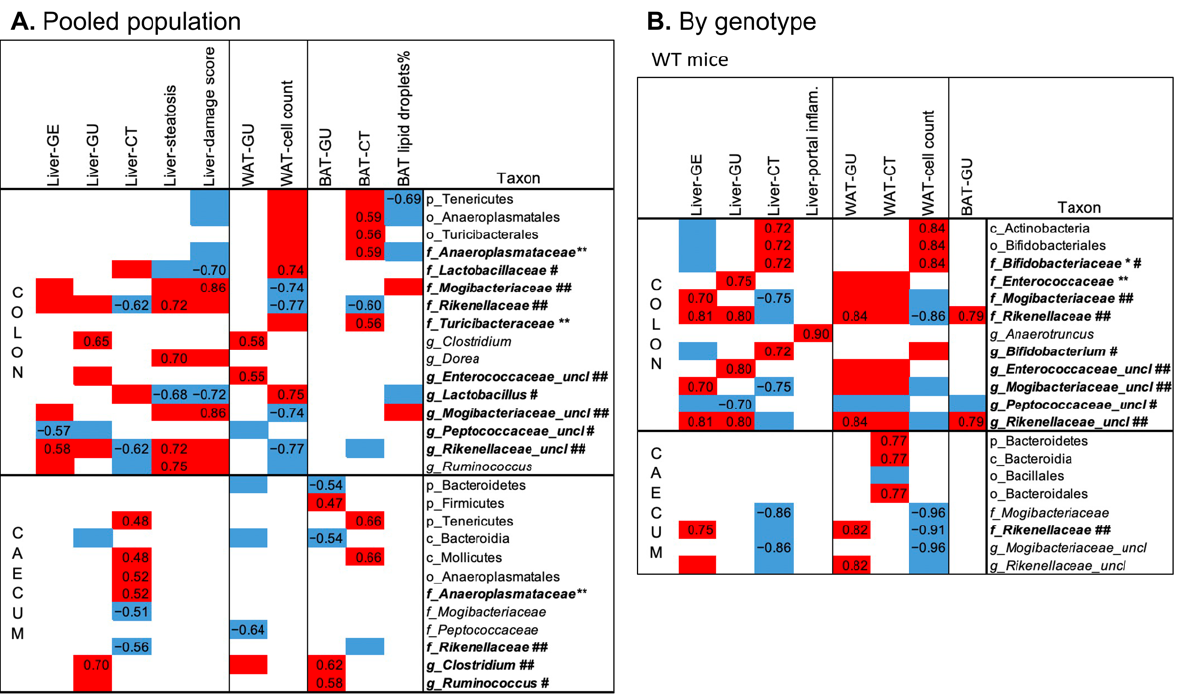
Figure 5. Top significant correlations between imaging and histological parameters and colon and caecum fecal microbiota, assessed in the pooled population ( A ) or the two genotypes separately ( B ). In the heatmaps, red and blue colors indicate positive and negative correlations, respectively. Spearman’s rho of correlations surviving FDR correction are reported, whereas for univariate correlations not surviving the FDR correction, Spearman’s rho are not reported, but the direction of the association is indicated by the red/blue color. Bold type and symbols are used to highlight metabolites previously shown to be higher (**) or lower (*) in the 3xTg compared to WT mice or shown to be higher (##) or lower (#) in HFD compared to ND fed mice.